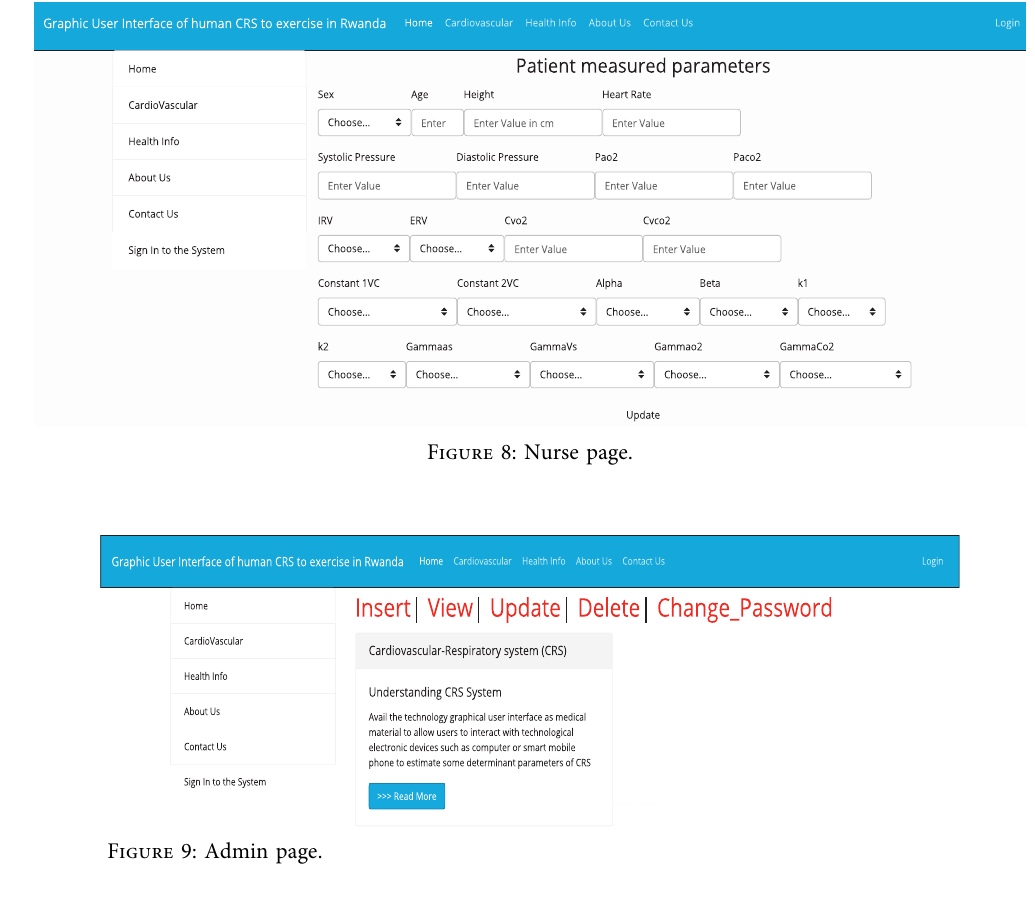
Table 4: Measured constants to use to run